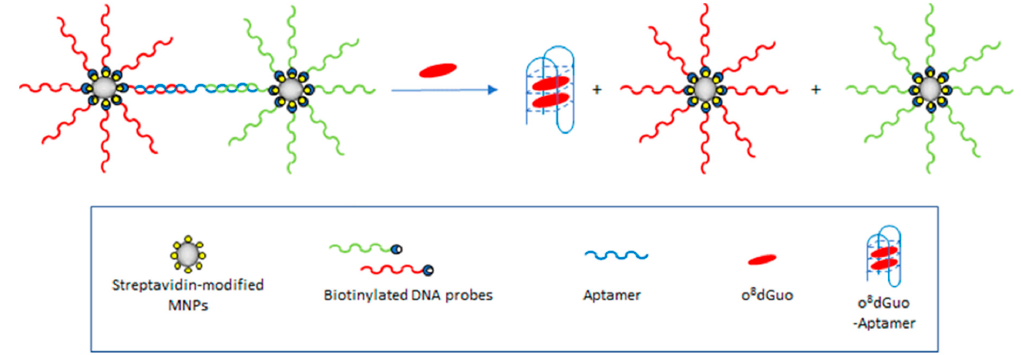
Figure 12. Magnetic nanoparticles in the resonance light scattering (RLS) probe for the detection of o 8 dGuo